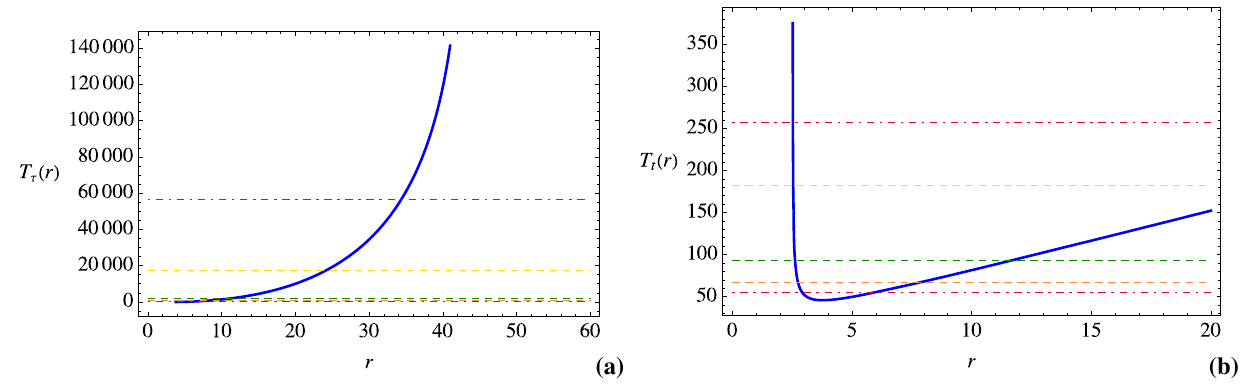
Fig. 13 The behavior of a the proper and b the coordinate periods of time-like circular orbits, in accordance with the values of L as in Fig. 9. In the diagrams, the red dot-dashed lines correspond to unstable cir-